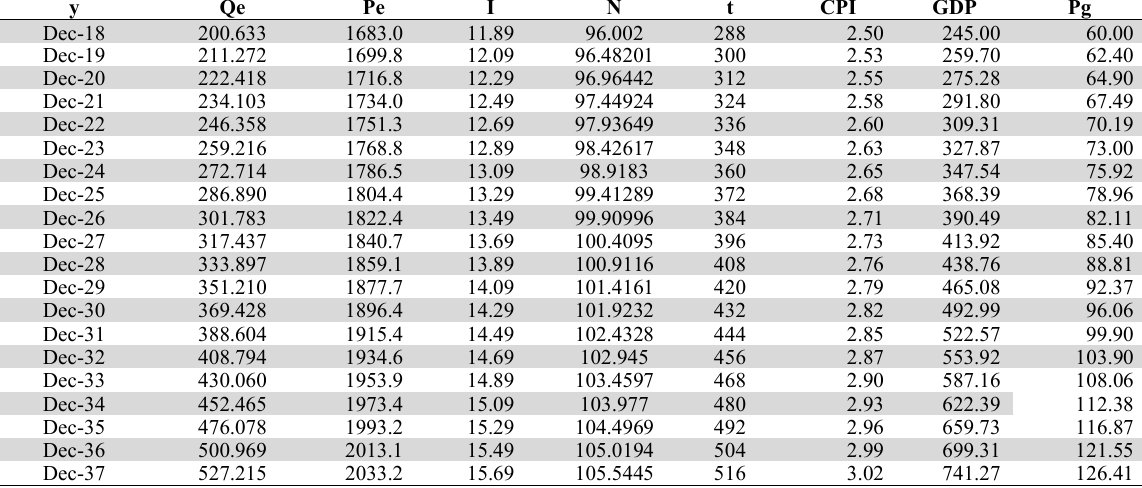
Table 1 The forecast of Vietnam electricity quantity demanded based on the demand function y Qe Pe I N t CPI GDP Pg Dec-18 200.633